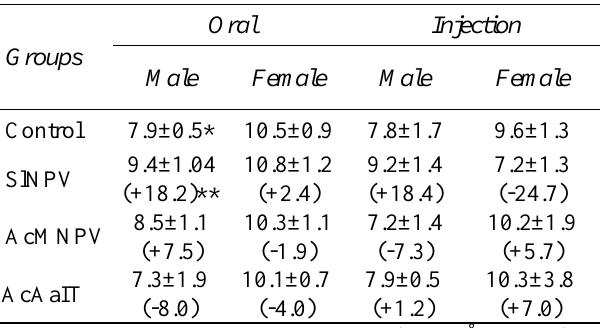
intraperitoneal injection treatment of rats with SlNPV, AcMNPVor AcAaIT.